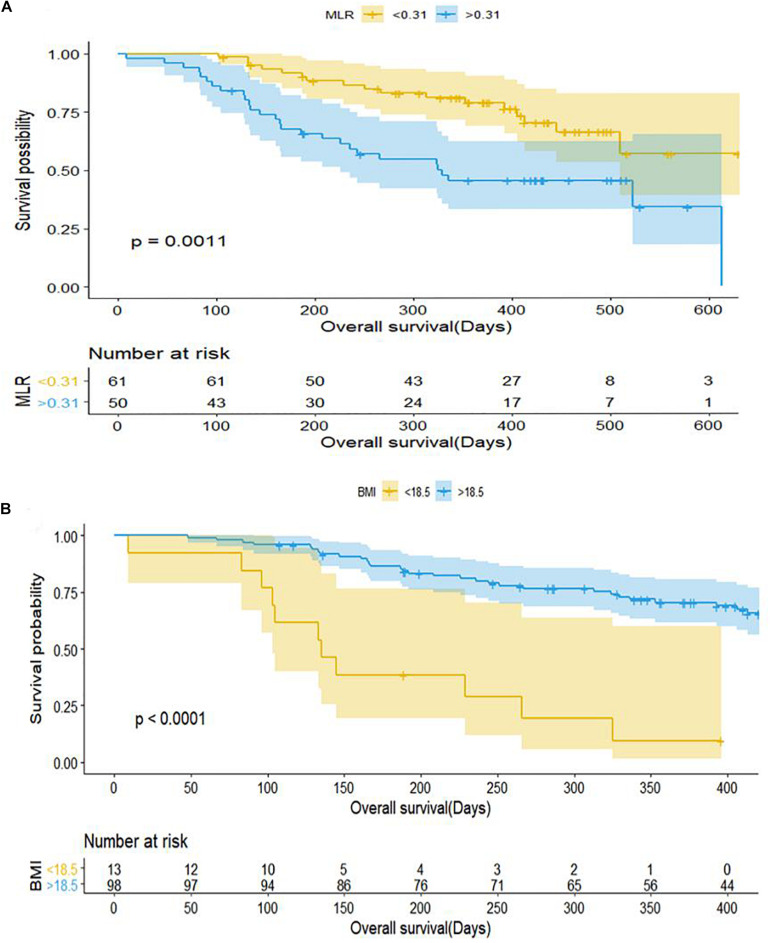
Kaplan–Meier curves of overall survival for patients with gastric cancer and colorectal cancer in relation to baseline clinical parameters. (A) MLR. (B) BMI. BMI, body mass index; MLR, monocyte-to-lymphocyte ratio.